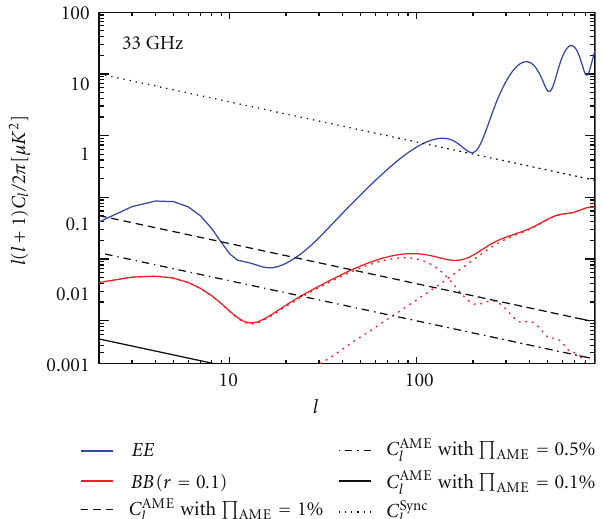
Figure 8: Contribution of the polarised AME to the (E and B) angular power spectrum at 33 GHz. The solid blue and red lines correspond to the CMB polarisation spectrum of E-modes and B-modes for the WMAP-7 cosmology [103] and assuming a tensor-to-scalar ratio of r = 0 . 1. Note that for the B-mode spectrum, the primordial tensor and lensing contributions are also plotted separately. The polarised AME power spectra ( C AME l ), for fractional polarisations Π AME equal to 1.0%, 0.5% and 0.1%, are shown as dashed, dotted-dashed, and dotted-dotted-dashed lines, respectively. For comparison, the synchrotron contribution at this frequency is also shown as a black dotted